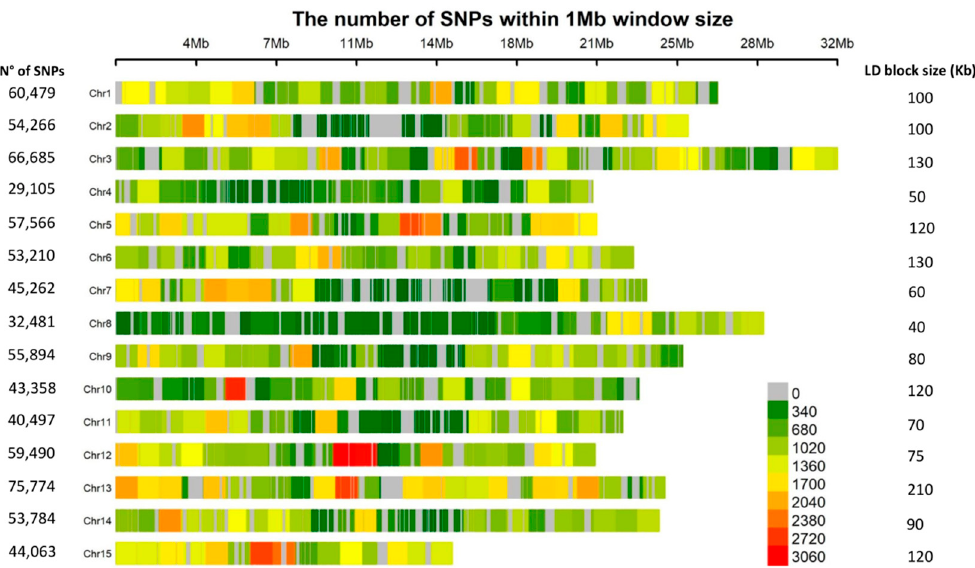
Figure 3. Single nucleotide polymorphism (SNP) density plot across the L. usitatissimum genome. Numbers of SNPs and LD blocks are also indicated for each of the 15 chromosomes.